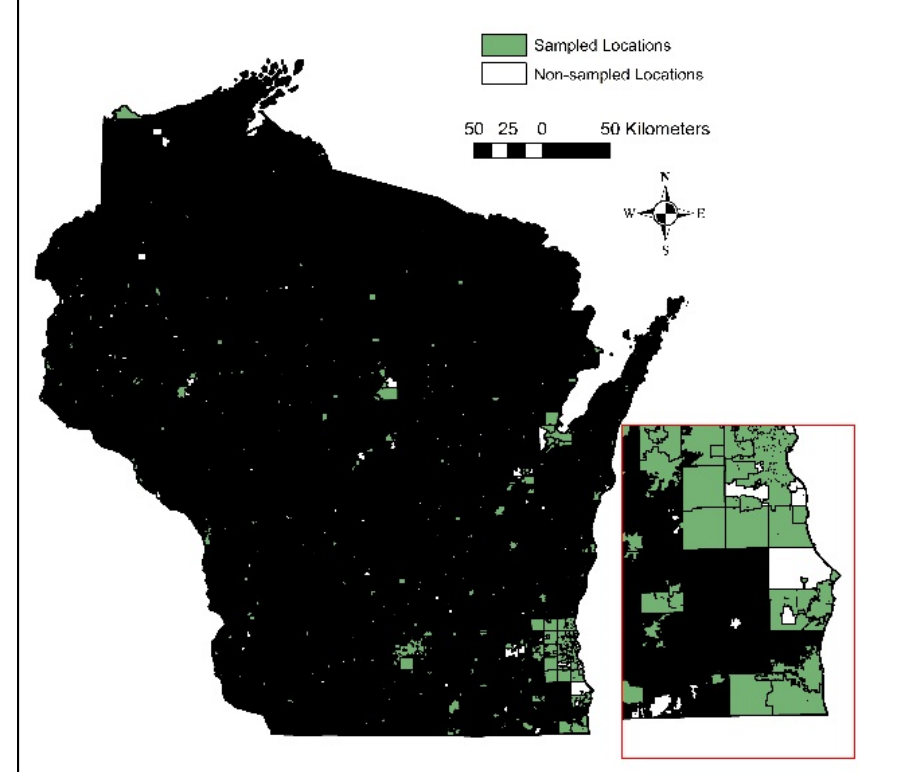
Figure 1. Study locations throughout the state of Wisconsin USA where urban tree canopy was sam- pled (shaded green) compared to non-sampled locations (unshaded white). Milwaukee metropolitan (bottom right) expanded to show greater sample clarity.